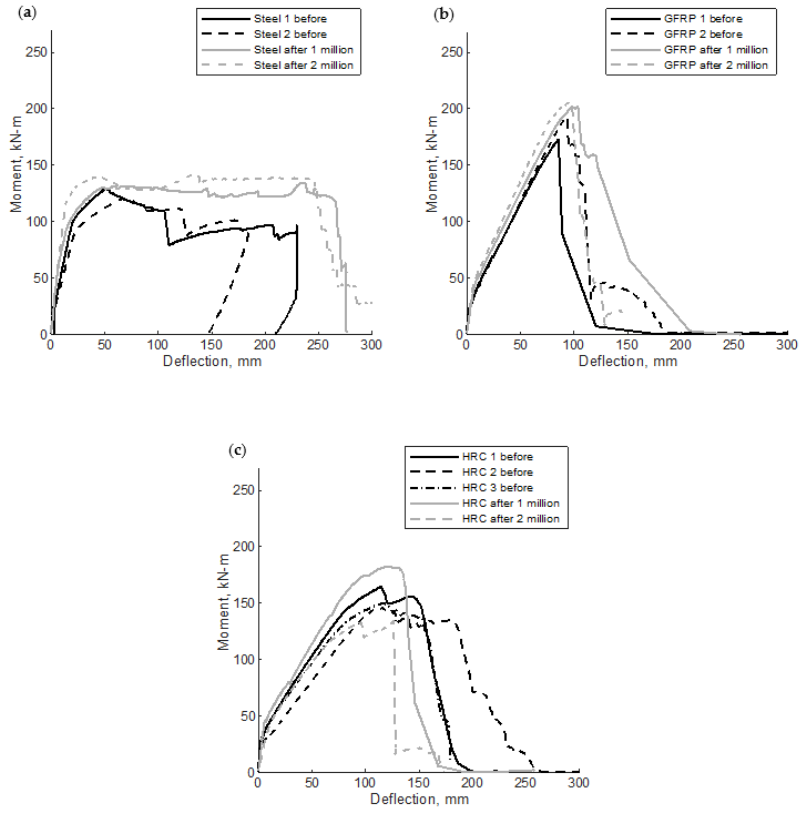
Figure 9. Moment-deflection relationships for static and post-fatigue flexural strength testing of ( a ) Steel, ( b ) GFRP, and ( c ) Hybrid specimens. ( a ) Steel, ( b ) GFRP, and ( c ) Hybrid